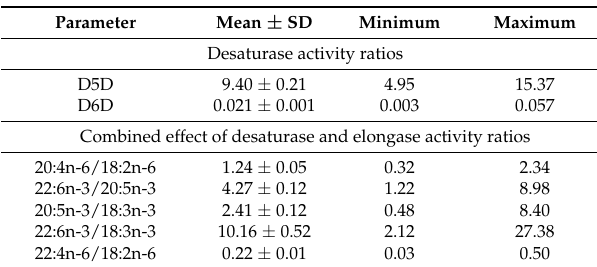
Table 5. Desaturase and elongase index